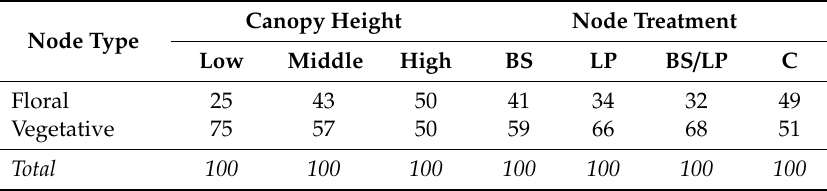
Table 1. The percentage of floral and vegetative nodes for each canopy height zone (low, middle, high) and for each node treatment (BS = bud shading; LP = leaf pluck; BS / LP = bud shading plus leaf pluck; C = control). Pearson’s chi-square test with canopy height, X 2 (2, N = 310) = 14.640, p = 0.001. Pearson’s chi-square test with node treatment, X 2 (3, N = 310) = 5.425, p = 0.143.